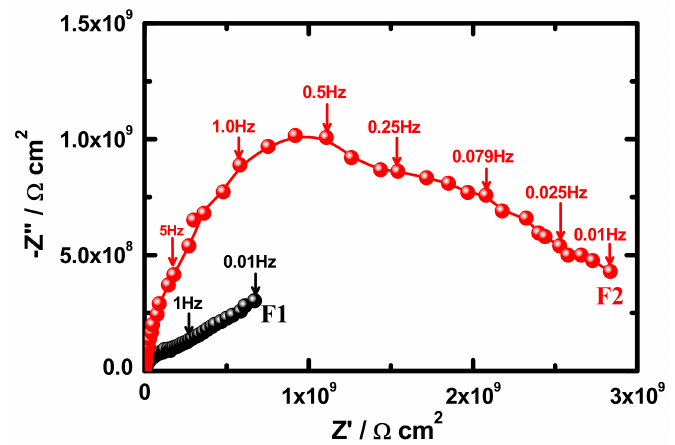
Figure 6. Nyquist plots obtained for coatings F1 and F2 after 1 h immersion in the 3.5% NaCl